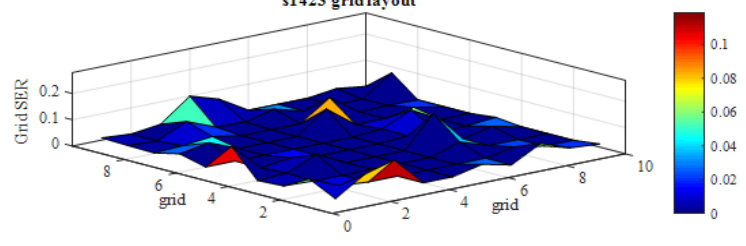
Figure 7. Grids SER for s1423